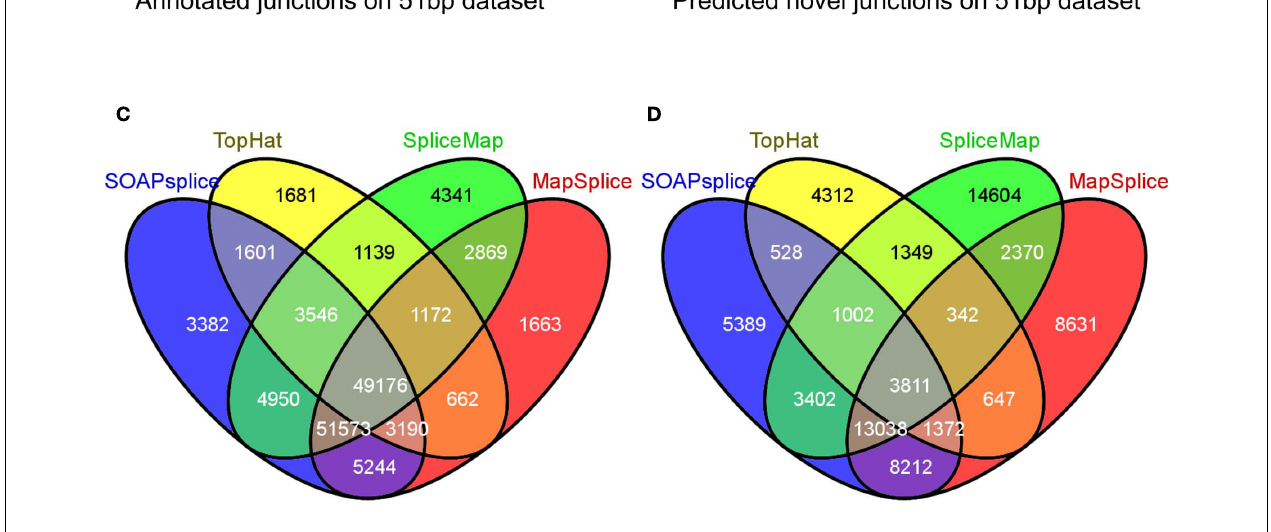
FIGURE 4 | Overlap of reported junctions for real dataset. Junctions identified by tools are classified as annotated junctions and predicted novel junctions. Annotated junctions are the ones that can be found in RefSeq annotation and the remaining junctions are defined as predicted novel